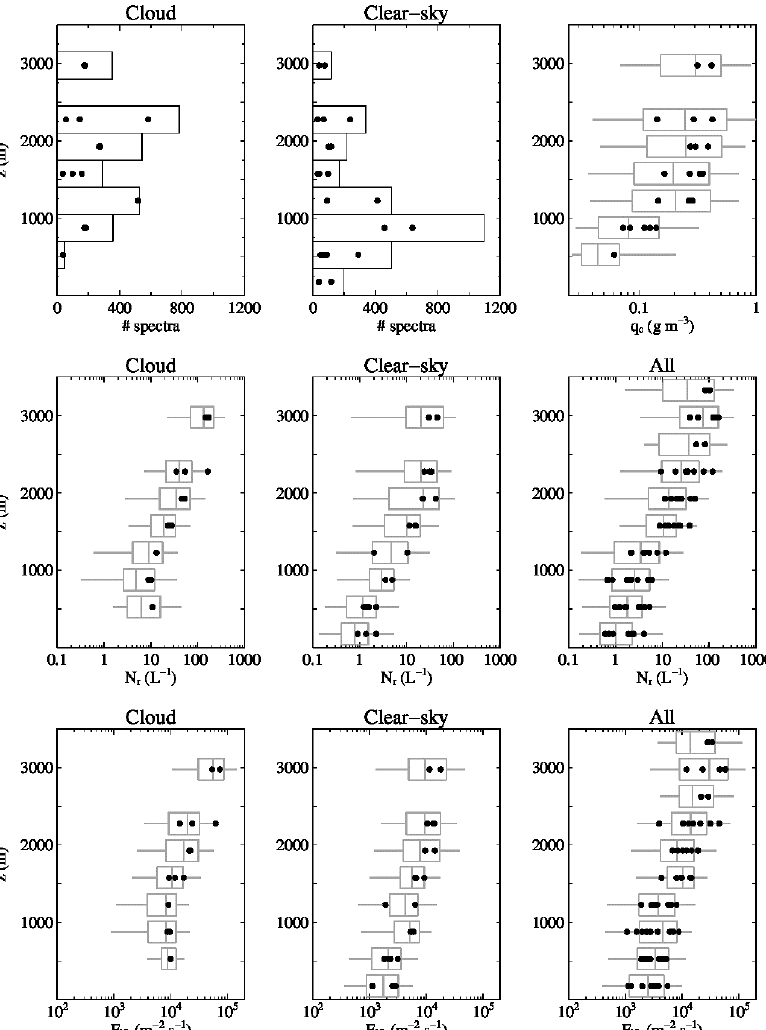
Figure 2. Total number of rain-sampled spectra in the cloud region (top row, left) and in clear sky (top row, center). Vertical profile of statistical distribution of cloud water content q c (top row, right) sampled at 1Hz for flights with FFSSP measurements available, and vertical profile of statistical distribution of the rain variables sampled at 1Hz for the rain concentration N r , the rain concentration flux F Nr , the rainwater content q r , the precipitation flux F qr and the rain mean volume diameter D v , in the cloud region (left) and in the clear-sky region (middle), for flights with FFSSP available, and in all regions (right). The box plots denote the 5th, 25th, 50th, 75th and 95th percentiles of the variable distribution in every 300m layer. Filled circles are mean values for each